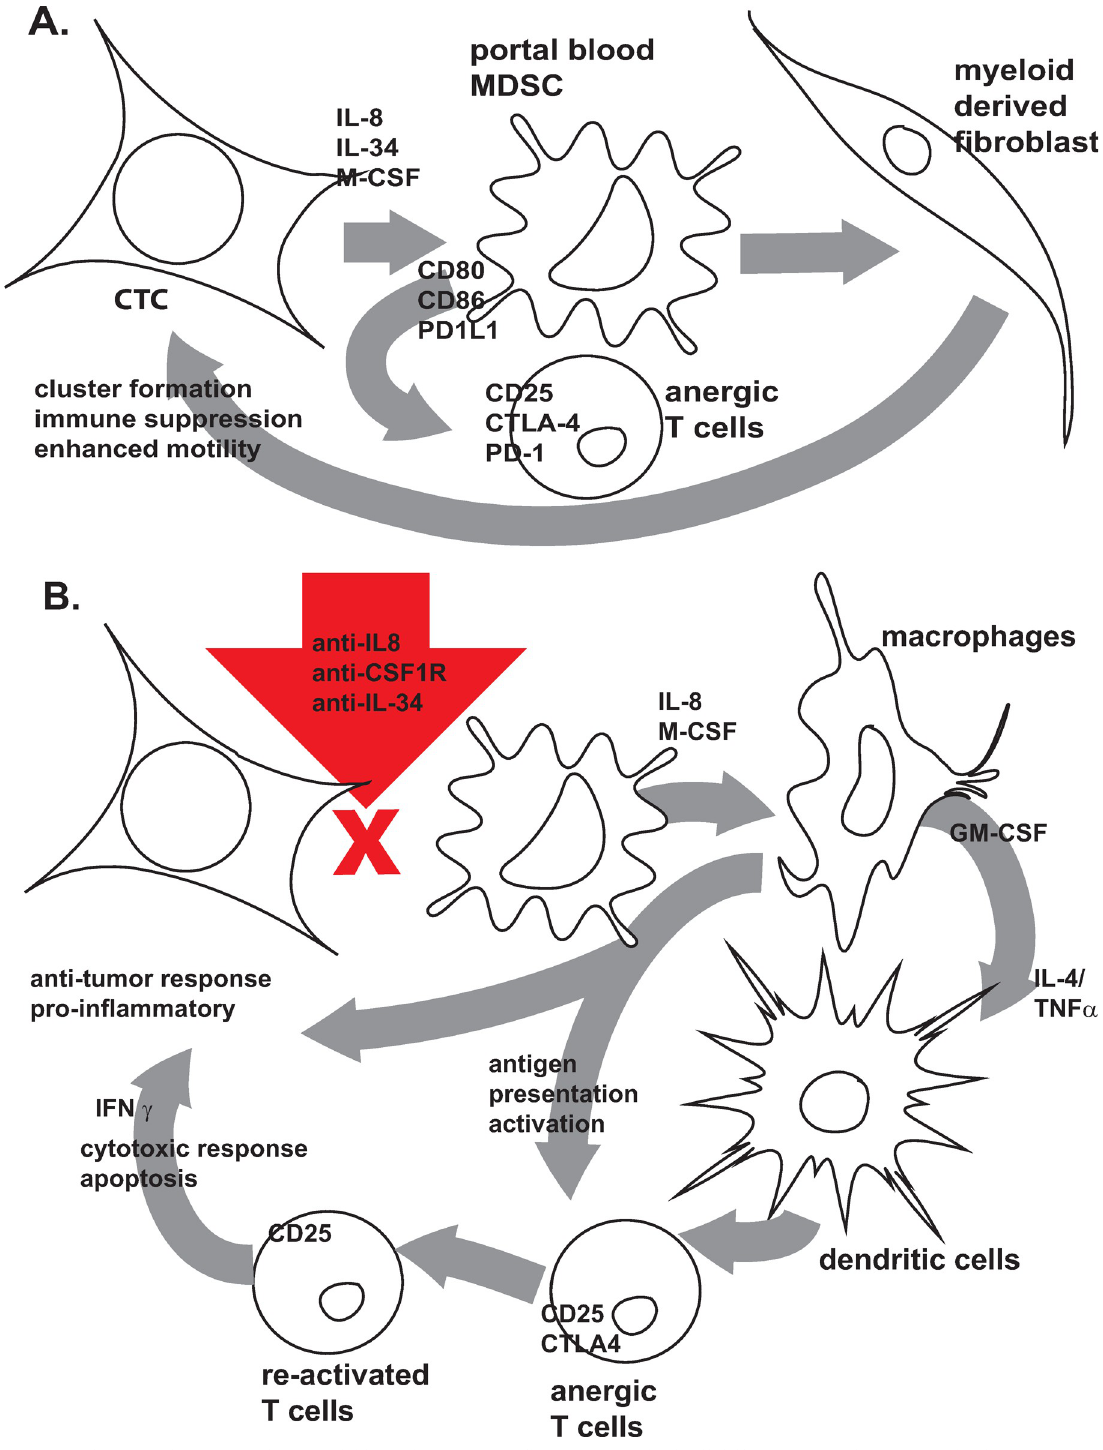
Fig 9. Mechanism of action working model hypothesis: CTC influence on myeloid cell differentiation plays a pivotal role in CTC survival and T cell immune response. A) PDAC CTC draw portal blood myeloid cells to them via IL-8 chemotaxis receptor CXCR2 signaling and then manipulate their differentiation to MDSC and further to M-FB through their production of high levels of IL-34 and M-CSF. These suppressor cell populations promote T cell anergy through PD-1 and CTLA4 as well as give CTC growth factors, metabolic support, motility enhancement, and immune suppressive protection. B) When IL-8-CXCR2 and IL-34/M-CSF-CSF1R signaling are